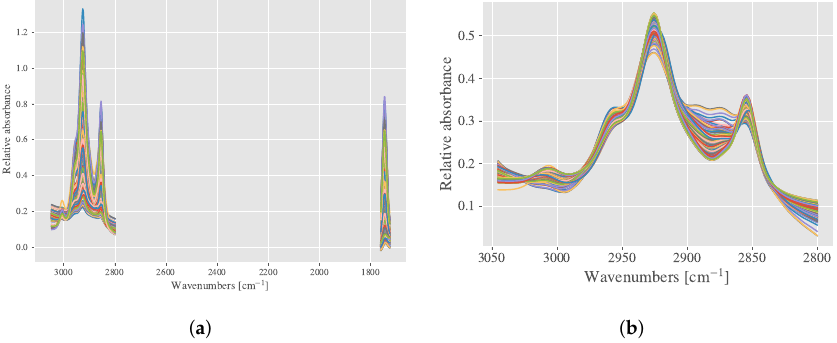
Figure 2. Different normalization strategies demonstrated on spectra of filamentous fungi. ( a ) Strategy A: the full spectra are first normalized with EMSC (described in the text), before the lipid regions are selected. ( b ) Strategy B: the lipid region at 2800–3590 cm − 1 is selected prior to EMSC normalization.